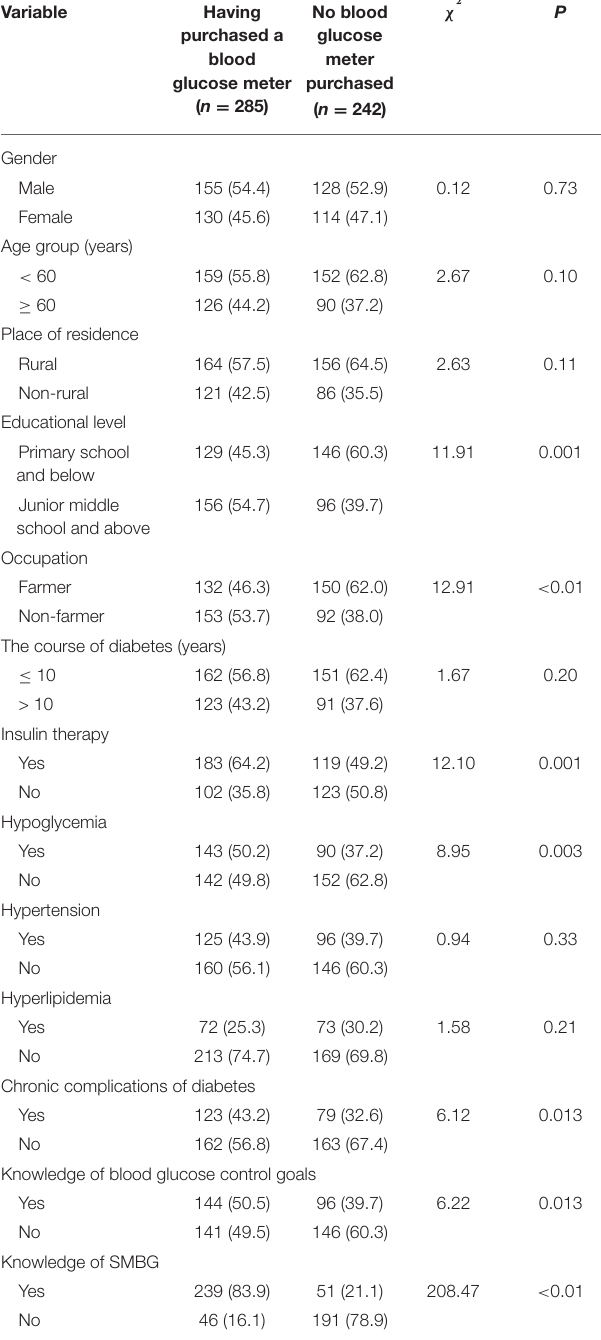
TABLE 1 | Univariate analysis of purchase of blood glucose meters among populations with different characteristics [ n (%)]. Variable